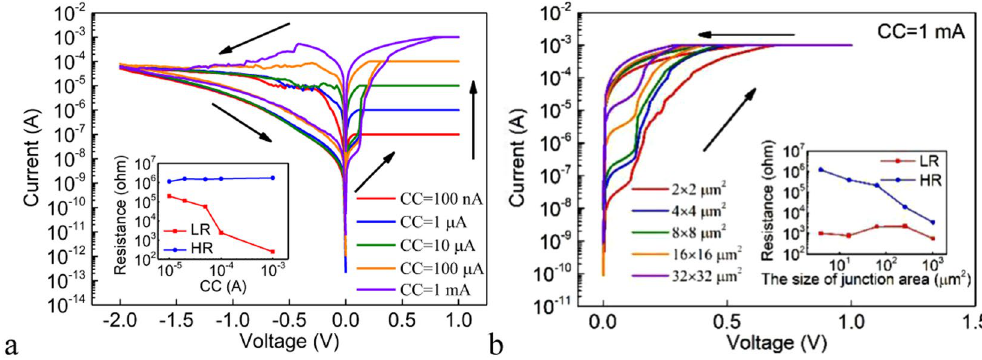
Figure 2. ( a ) The DC I-V curves under the different SET CCs for the Ag/Ge 2 Sb 2 Te 5 /Pt cell. Inset: the dependence of the LR and HR on the CC for the Ag/Ge 2 Sb 2 Te 5 /Pt cell. ( b ) The DC I-V curves of the SET processes for Ag/Ge 2 Sb 2 Te 5 /Pt devices with different sizes of the junction areas under the SET CC of 1 mA. Inset: the dependence of the LR and HR on the size of the junction area for the Ag/Ge 2 Sb 2 Te 5 /Pt